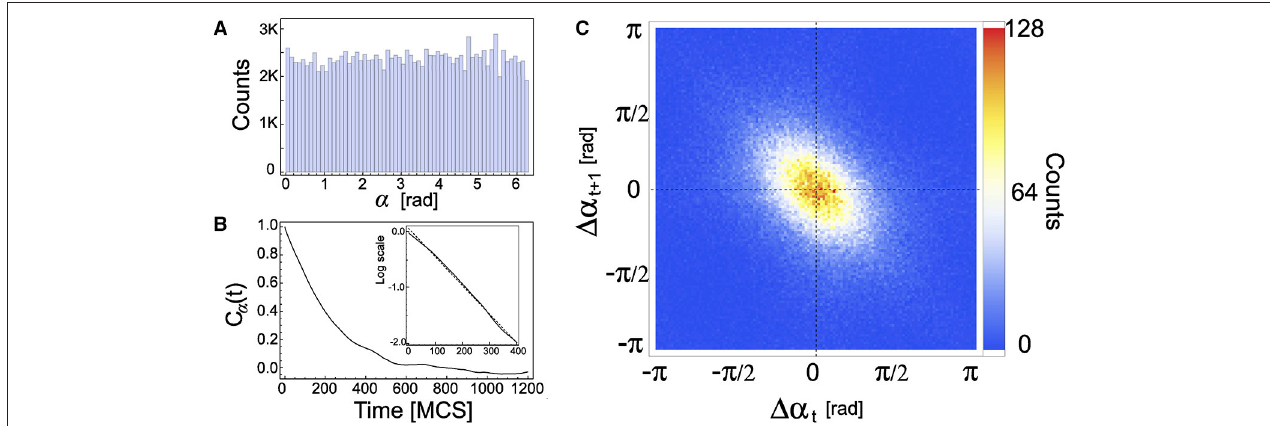
FIGURE 3 | (A) Frequency distribution of cell displacement angle α for all cells during 4,000 MCS. (B) The autocorrelation of α , C α , as a function of time. Inset: log scale of C α showing the region of exponential decay (short times). (C) 2D-histogram of the turn angle ( 1α t versus 1α t + 1 ), showing that two consecutive turn angles are anti-correlated. Parameters used: ρ = 0.2, τ = 10 MCS, and φ = 0.95.